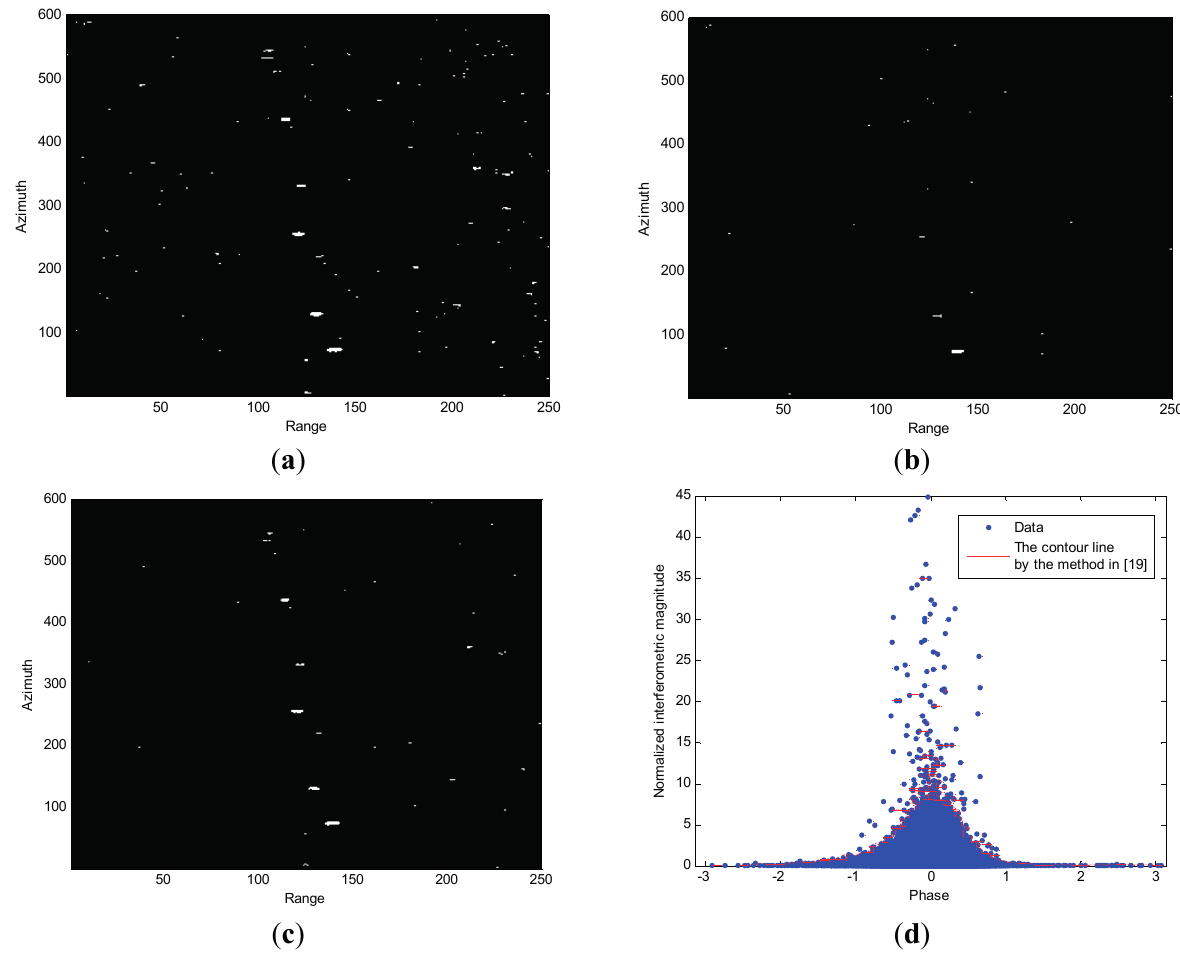
Figure 9. Detection results of the method in [20]: (a) Binary output with the bin numbers at 2000 × 100 (range × azimuth); (b) Binary output with the bin numbers at 100 × 50 (range × azimuth); (c) Binary output with the bin numbers at 1000 × 50 (range × azimuth); (d) The obtained contour line for detection in